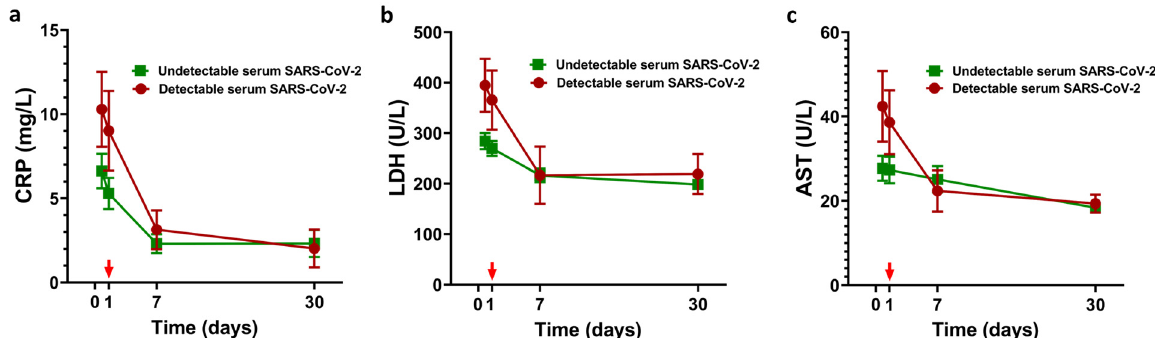
Figure 4. Longitudinal measurements of selected factors. Analysis of CRP ( a ), LDH ( b ), and AST ( c ) levels from baseline at day 0 to 30 days after LDRT. Treatment with LDRT was performed on day 1, indicated with a red arrow. Two-tailed Wilcoxon signed rank test did not show significant p values. SEM values are plotted.